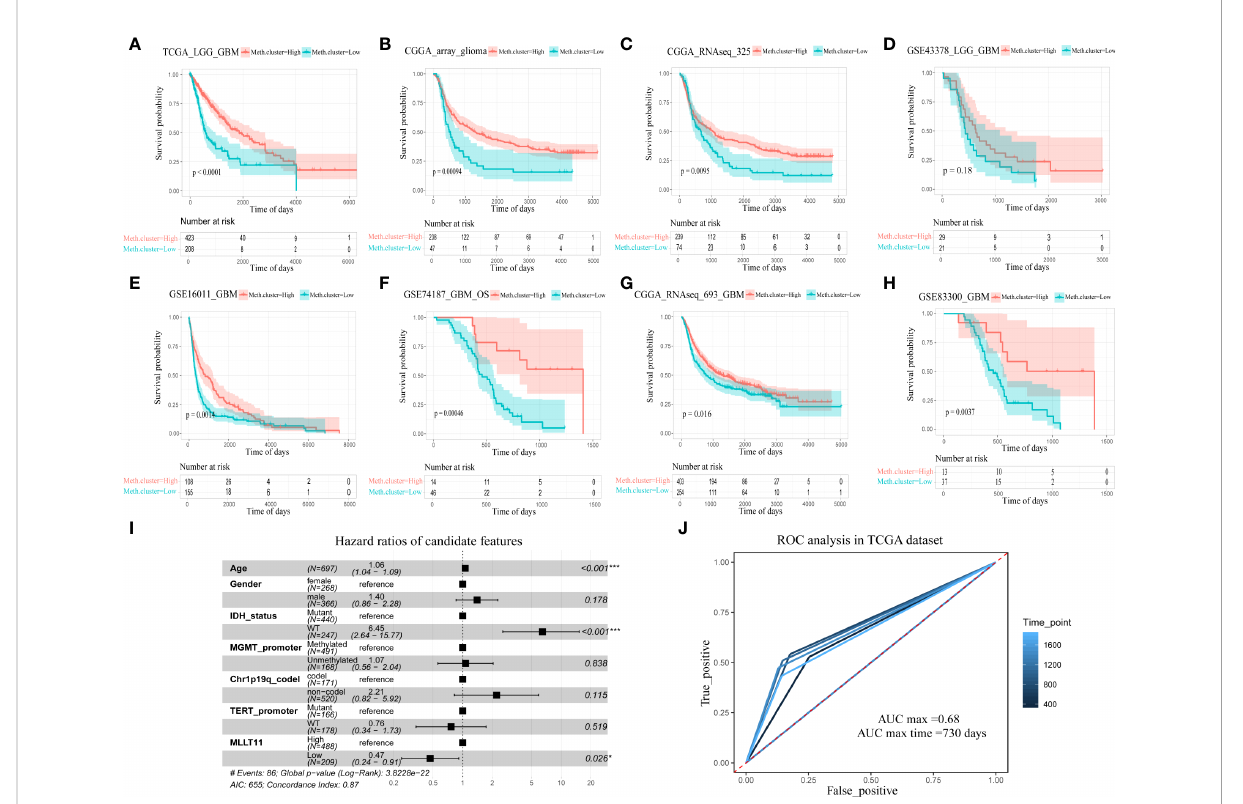
FIGURE 3 The relationship between MLLT11 expression and survival for glioma. (A – H) Kaplan – Meier plots of MLLT11 in TCGA and CGGA datasets, (A) TCGA_LGG_GBM, (B) CGGA_array, (C) CGGA_325, (D) GSE43378, (E) GSE16011, (F) GSE74187, (G) CGGA_693, and (H) GSE82009. (I) The forest diagram represents the multifactor Cox regression analysis in which the variables include MLLT11, gender, age, IDH mutation status, 1p19q deletion status, MGMT methylation, and TERT promoter status. (J) ROC curve analysis of the model in pan-glioma cohort in TCGA dataset. *p < 0.05, **p < ***p <